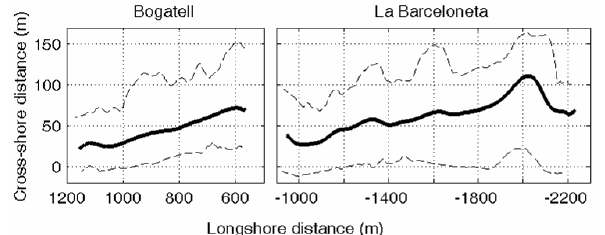
Fig. 3. Bogatell (left) and La Barceloneta (right) planviews on 3 November 2003. The coloured line indicates the shoreline location before the southern storm event, on 30 October 2003, showing beach rotation at the Bogatell beach and the formation of megacusp and shoreline retreat at La Barceloneta beach.